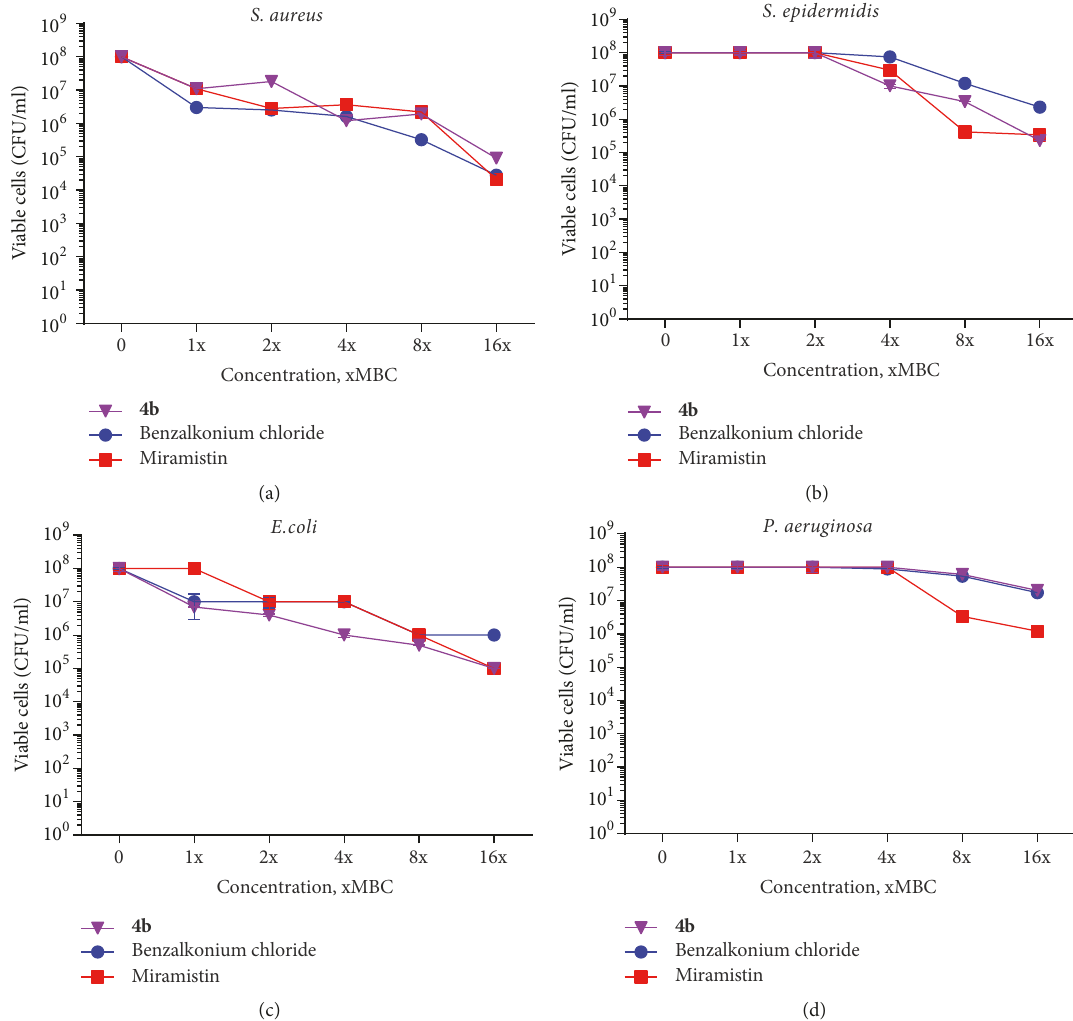
Figure 3: Antimicrobial effect of 4b on biofilm-embedded